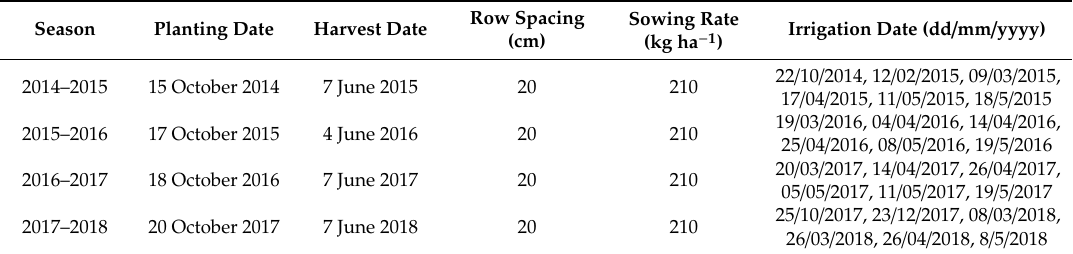
Table 3. Field and crop management for the winter wheat from 2014 to